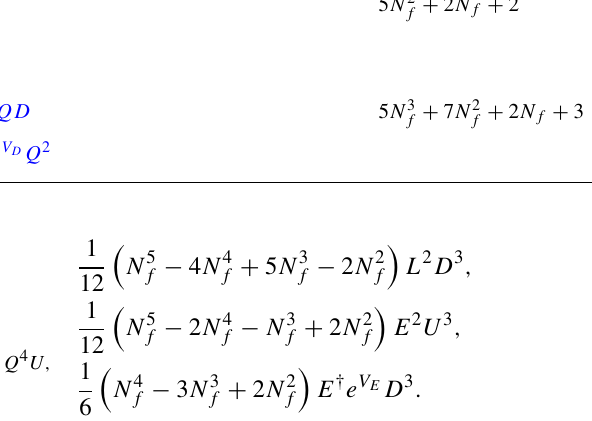
Table 25 MSSM: Operators composed of chiral as well as vector superfields. The operators in blue have distinct hermitian conjugates which we have not written explicitly. Boxed operators vanish for N f = 1 Operators No. of Operators (including h.c.) Operators of Canonical